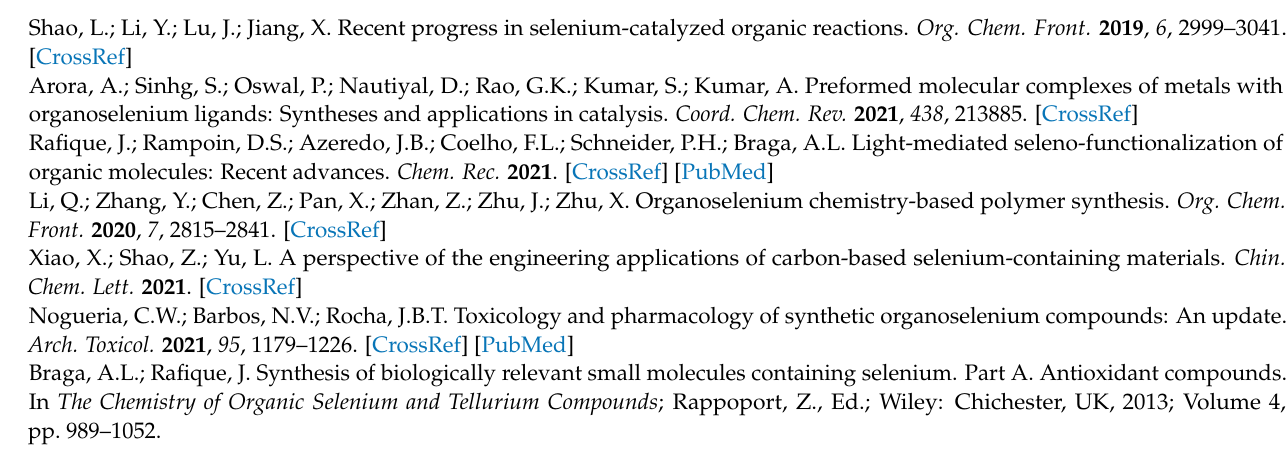
15 × 10 − 3 mol L − 1 , respectively. The red line represents the Michaelis-Menten fit. Figure S35: Initial rate ( V 0 ) plotted against substrate concentration. The initial rates were calculated from at least two experiments for each concentration of PhSH. The concentrations of 3a and H 2 O 2 were fixed at 5 × 10 − 5 and 15 × 10 − 3 mol L − 1 , respectively. The red line represents the Michaelis-Menten fit. Figure S36: Initial rate ( V 0 ) plotted against substrate concentration. The initial rates were calculated from at least two experiments for each concentration of PhSH. The concentrations of 3b and H 2 O 2 were fixed at 5 × 10 − 5 and 15 × 10 − 3 mol L − 1 , respectively. The red line represents the Michaelis- Menten fit. Figure S37: Initial rate ( V 0 ) plotted against substrate concentration. The initial rates were calculated from at least two experiments for each concentration of PhSH. The concentrations of 3d and H 2 O 2 were fixed at 5 × 10 − 5 and 15 × 10 − 3 mol L − 1 , respectively. The red line represents the Michaelis-Menten fit. Figure S38: Initial rate ( V 0 ) plotted against substrate concentration. The initial rates were calculated from at least two experiments for each concentration of PhSH. The concentrations of 3e and H 2 O 2 were fixed at 5 × 10 − 5 and 15 × 10 − 3 mol L − 1 , respectively. The red line represents the Michaelis-Menten fit. Table S1: Atomic charges of nitrogen and selenium according to NPA. Table S2: Donor-acceptor second order perturbation analysis. Table S3: DFT-computed energies for optimized geometries (in